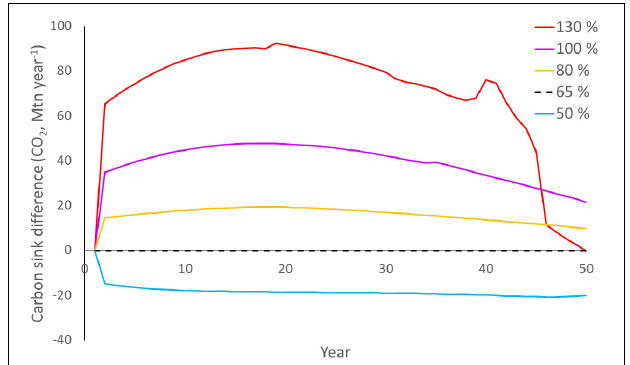
FIGURE 3 | The annual difference of the carbon sink (CO 2 , Mtn year - 1 ) between each scenario and the baseline (65% of CAI), i.e., Sink i = Sink S i − Sink B i , where Sink S i = sink of scenario S at year i and Sink B i = sink of baseline scenario at year i. In the sink, we included CO 2 stored in different tree compartments, soil carbon, and harvested wood products (HWP). Negative values denote larger carbon sink than in